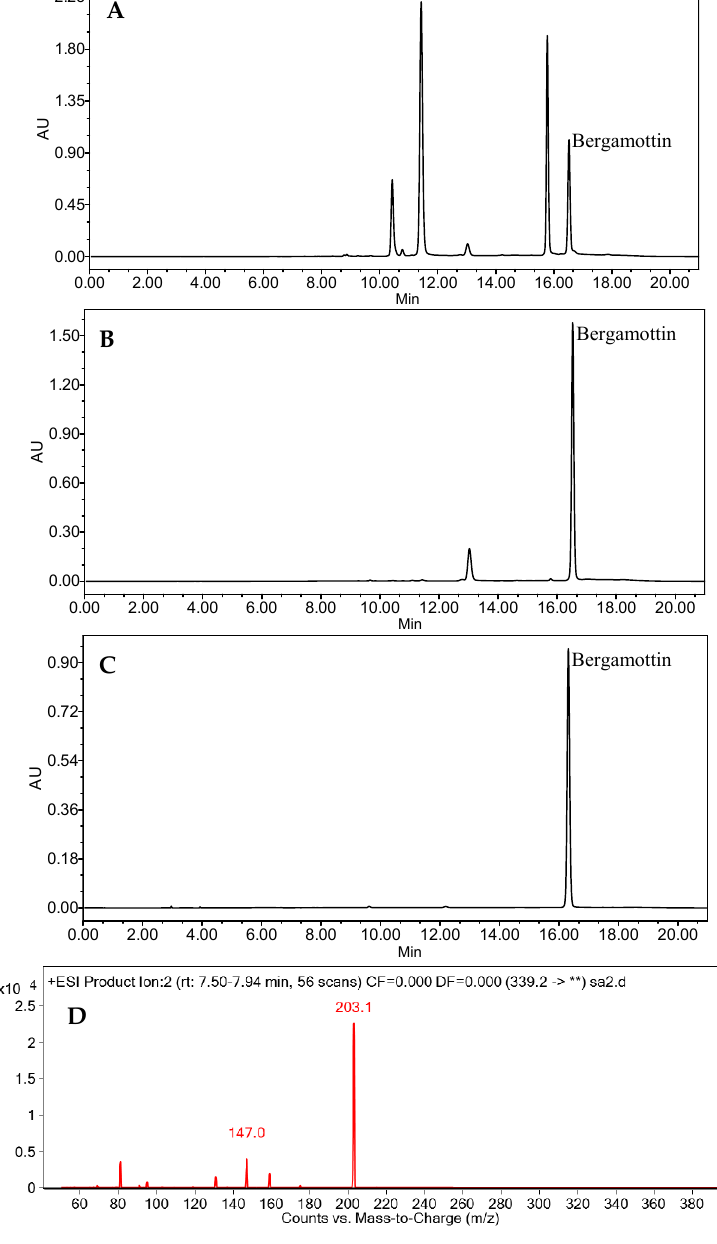
Figure 3. HPLC chromatogram of crude extract before ( A ) and after ( B ) treatment with silica gel column; the HSCCC purified product ( C ); LC-MS 2 chromatogram of the final purified bergamottin ( D ) ( λ = 250 nm). Table 3. The purities and recoveries of bergamottin in the two-step purification